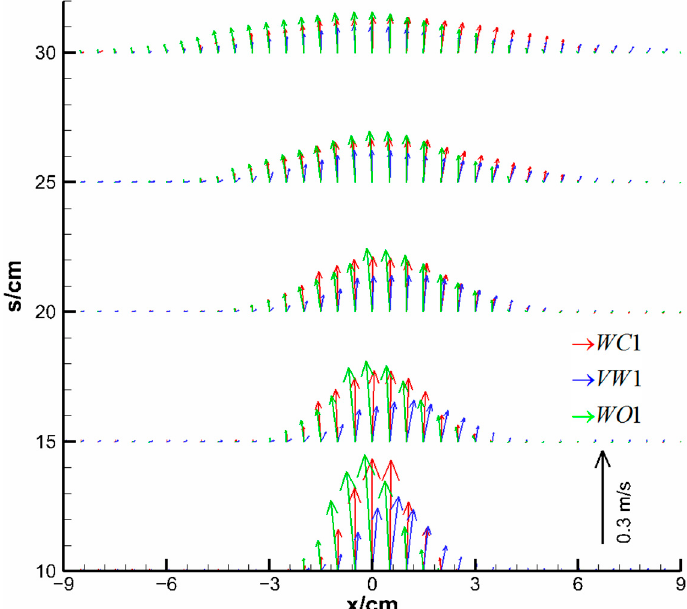
Figure 12. Time-averaged velocity vectors for VW1, WC1 and WO1 in Table 1.